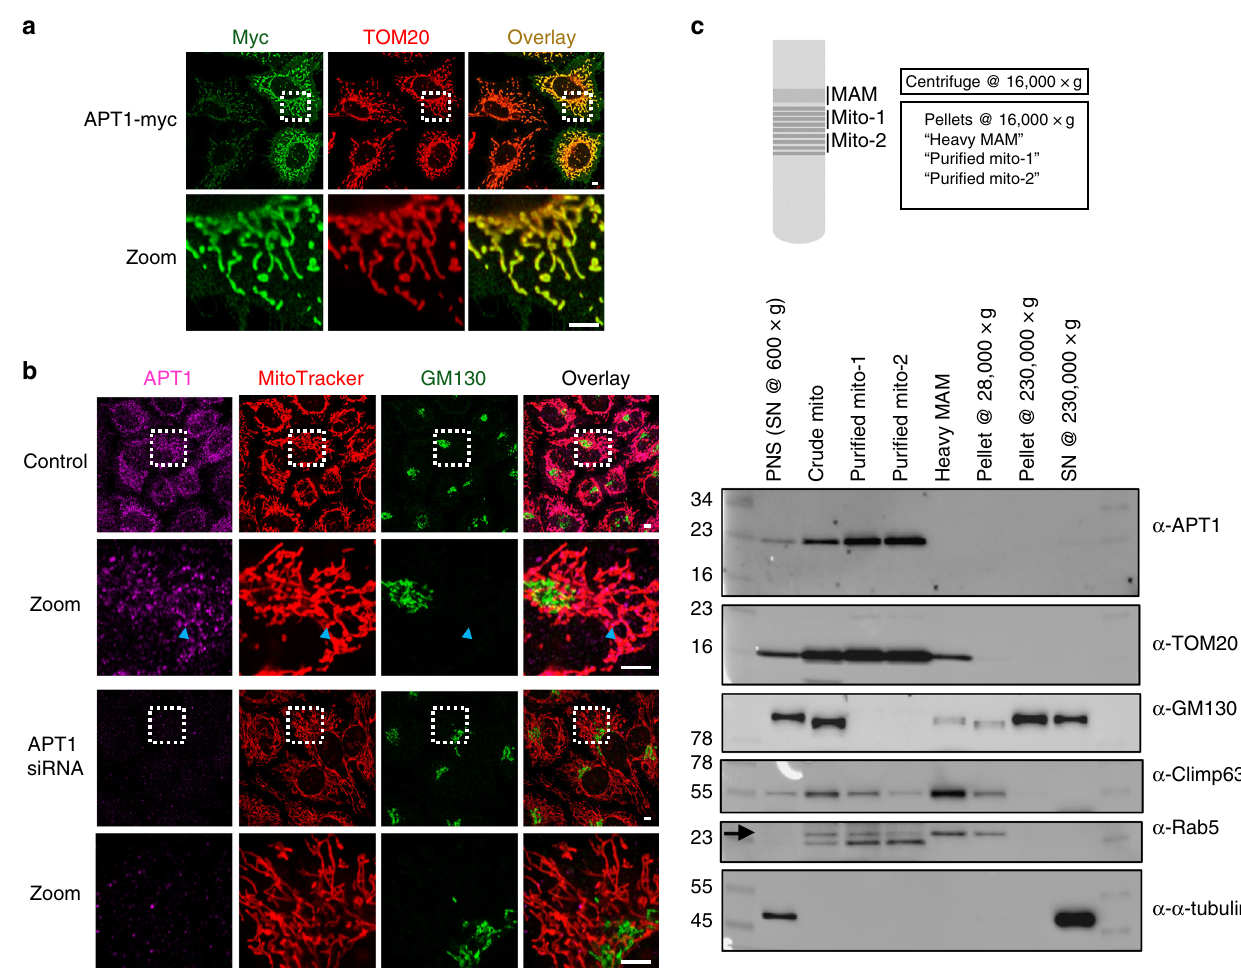
Fig. 7 Immunostaining and subcellular fractionation experiments reveal APT1 is localized in mitochondria. a Immunostaining of HeLa cells overexpressing APT1 with a myc tag reveals APT1 localized to mitochondria. 5 µ m scale bars shown. b Immunostaining of endogenous APT1 in HeLa cells con fi rms APT1 is predominantly localized in mitochondria mitochondria (e.g., co-localization pointed by the blue arrows). Knockdown of APT1 by RNAi con fi rms that the measured signal is due to APT1. 5 µ m scale bars shown. c HeLa cells were fractionated to isolate mitochondria by means of differential centrifugation and a continuous Percoll gradient 63 (Supplementary Fig. 23). Fractions recovered at different steps of the protocol were loaded in an SDS-polyacrylamide gel (10 µ g of total protein per lane) and analyzed by western blot. The fractions that are highly enriched for mitochondria (high Tom20, low alpha-tubulin and GM130) display the highest levels of APT1, con fi rming the immunostaining experiments and demonstrating APT1 is predominantly localized in mitochondria. In the anti-Rab5 panel, the upper bands (arrow) correspond to Rab5. The lower bands in this panel correspond to Tom20 staining since the nitrocellulose membrane used for Tom20 staining was reblotted with anti-rab5 antibody. Similar enrichment patterns were observed for all antibodies in at least four independent fractionation experiments. Numbers on the left indicate protein sizes of the corresponding bands of the molecular weight